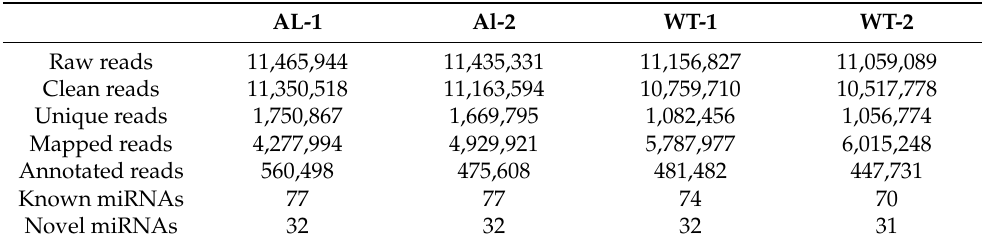
Table 2. Overall statistics based on the reads of the miRNA sequencing